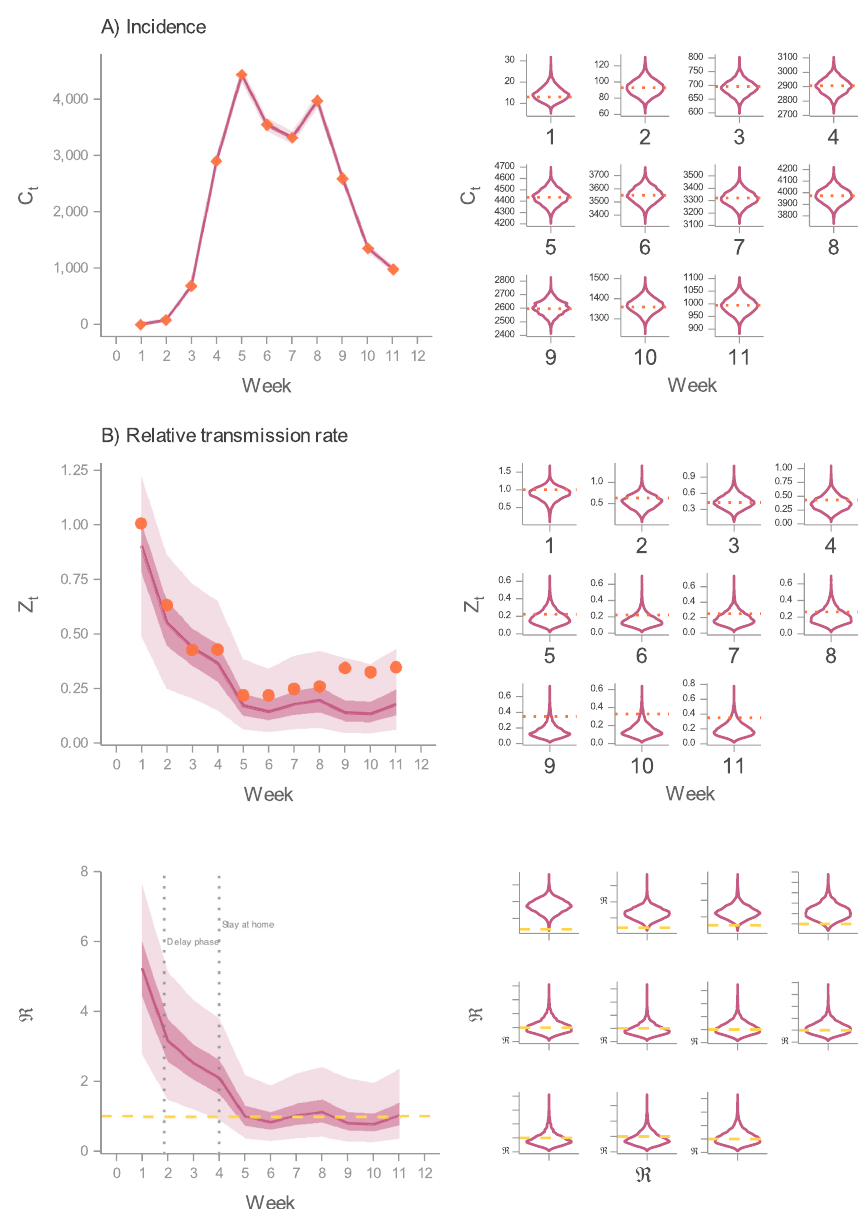
Fig 5. Inference on DGP2. In these three figures, the predicted values stem from DGP2’s filtering distribution. Further, in the LHS, the solid line indicates the median, and the darker and lighter ribbons represent the 50% and 95% CI, respectively. (A) Comparison between the predicted incidence (solid line and ribbons in the LHS; violin plots in the RHS) and weekly detected cases from Ireland’s first COVID-19 wave (rhombi in the LHS; horizontal dotted lines in the RHS). (B) Comparison between the predicted relative transmission rate (solid line and ribbons in the LHS; violin plots in the RHS) compared to Apple’s mobility indexes in Ireland (points in the LHS; horizontal dotted lines in the RHS). (C) Predicted effective reproduction number (solid line and ribbons in the LHS; violin plots in the RHS). Horizontal dashed lines denote the epidemics threshold.